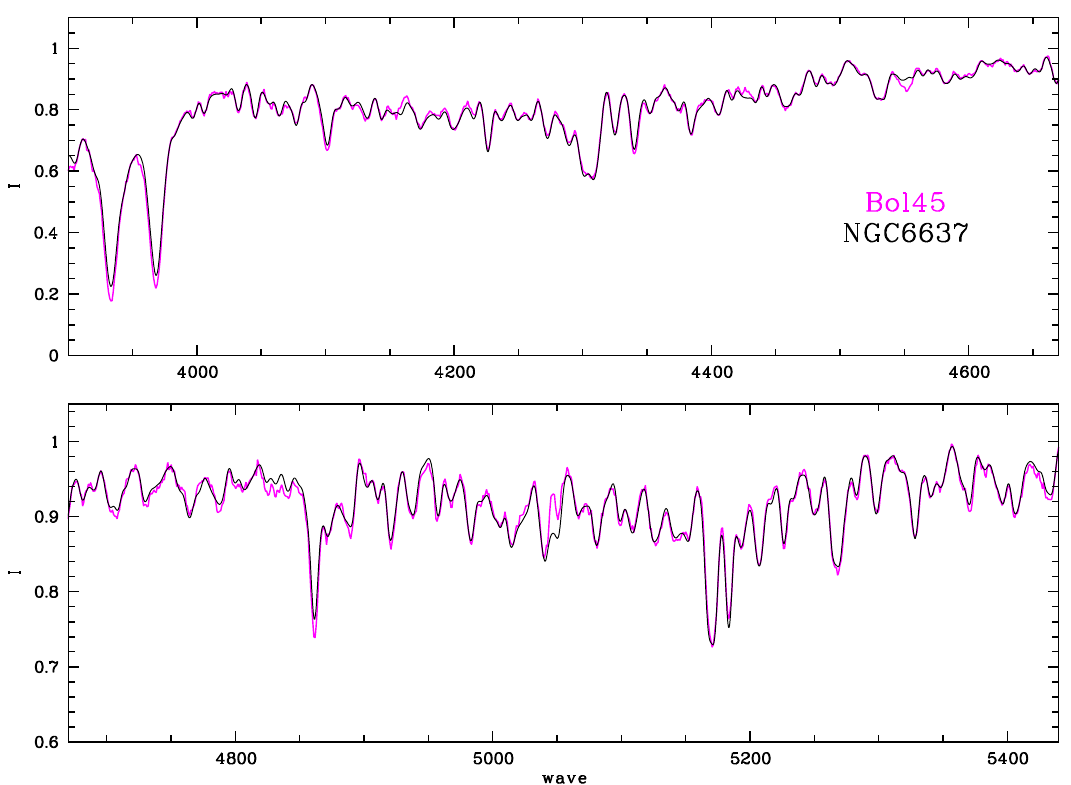
Figure 8: The IL spectrum of Bol 45 from MMI21 ( magenta ) in comparison with the spectrum of Galactic GC NGC 6637 ( Schiavon et al . 2005 ) ( black )